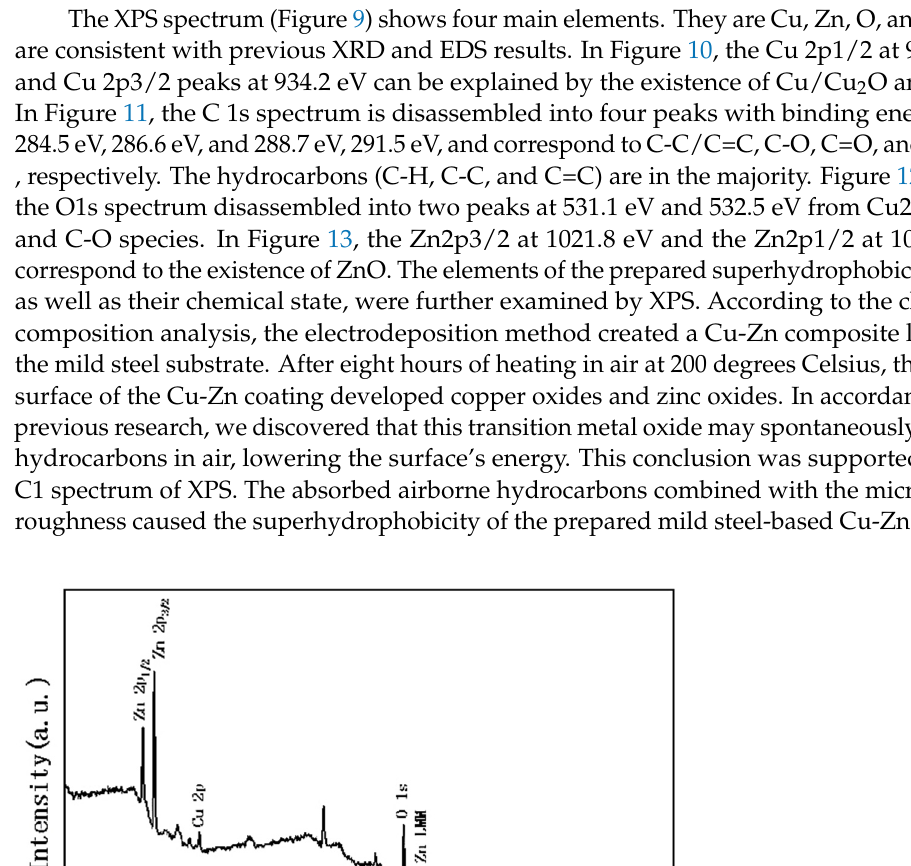
Figure 8. EDS spectrum of prepared Cu-Zn superhydrophobic surfaces.